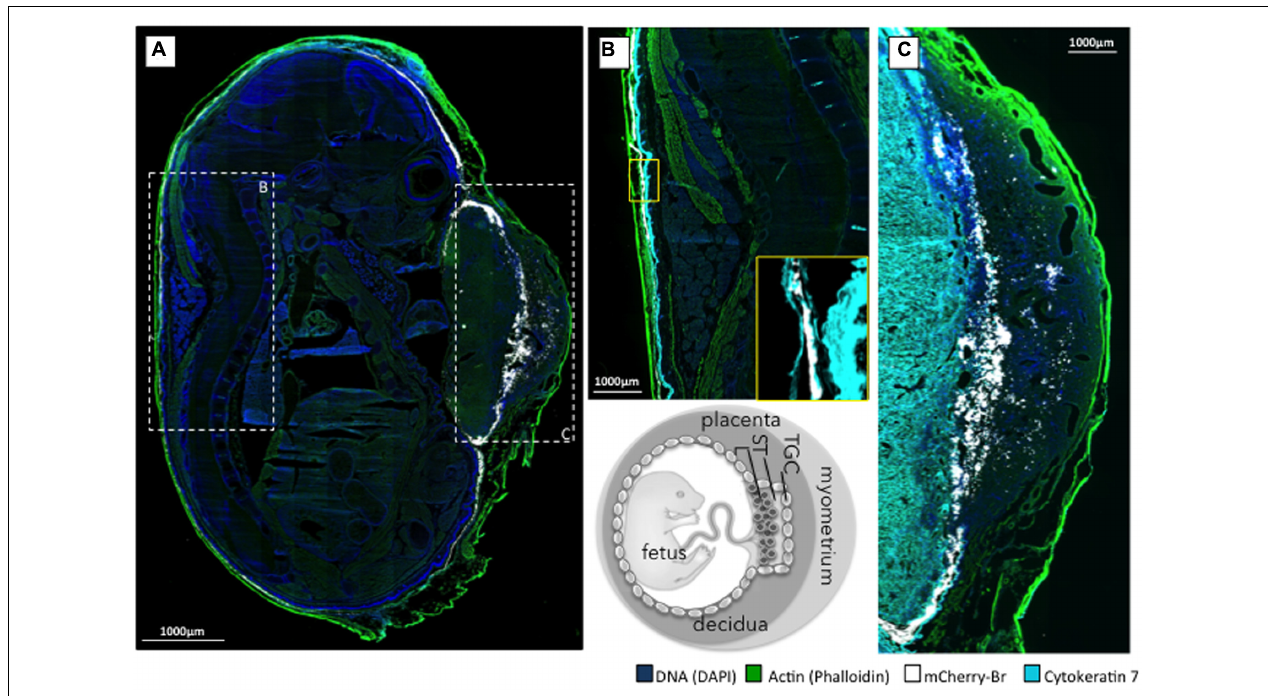
FIGURE 7 | Localization of B. abortus 2308 in murine conceptus. Pregnant mice were infected intraperitoneally at 6 days post-conception with 10 5 CFU of B. abortus mCherry (white), and the conceptuses were obtained at post-conception day 15. (A) Mosaic reconstitution (210 individual images taken at 10 × magnification) of a sagittal section of an infected murine conceptus stained for DNA (DAPI/blue) and actin (phalloidin/green); dashed squares B and C circumscribe the prototypal zone corresponding to (B,C) . (B) Cytokeratine-7 immunostaining (light blue) of trophoblastic cells of the dorsal part of the conceptus with a close up of the infected trophoblastic cells lining the decidua parietalis (yellow square). (C) Cytokeratine-7 immunostaining (light blue) of the placenta at the level of the decidua basalis. TGC, trophoblast giant cell; ST, spongiotrophoblast; L,